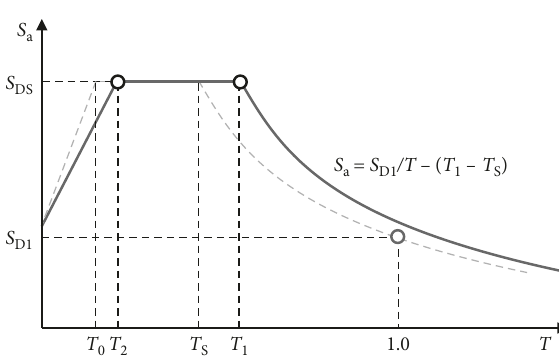
Figure 15: New form of design response spectrum